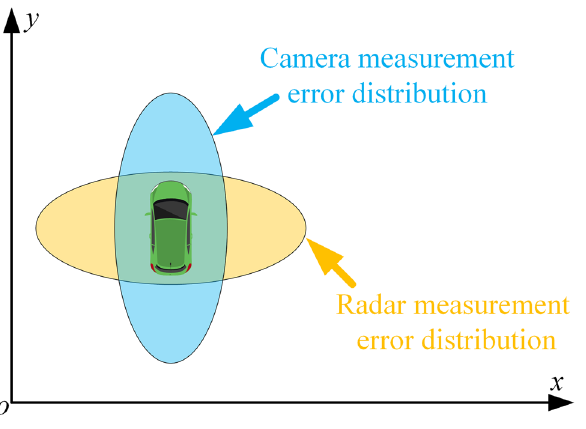
Figure 6. Measurements error distribution for different